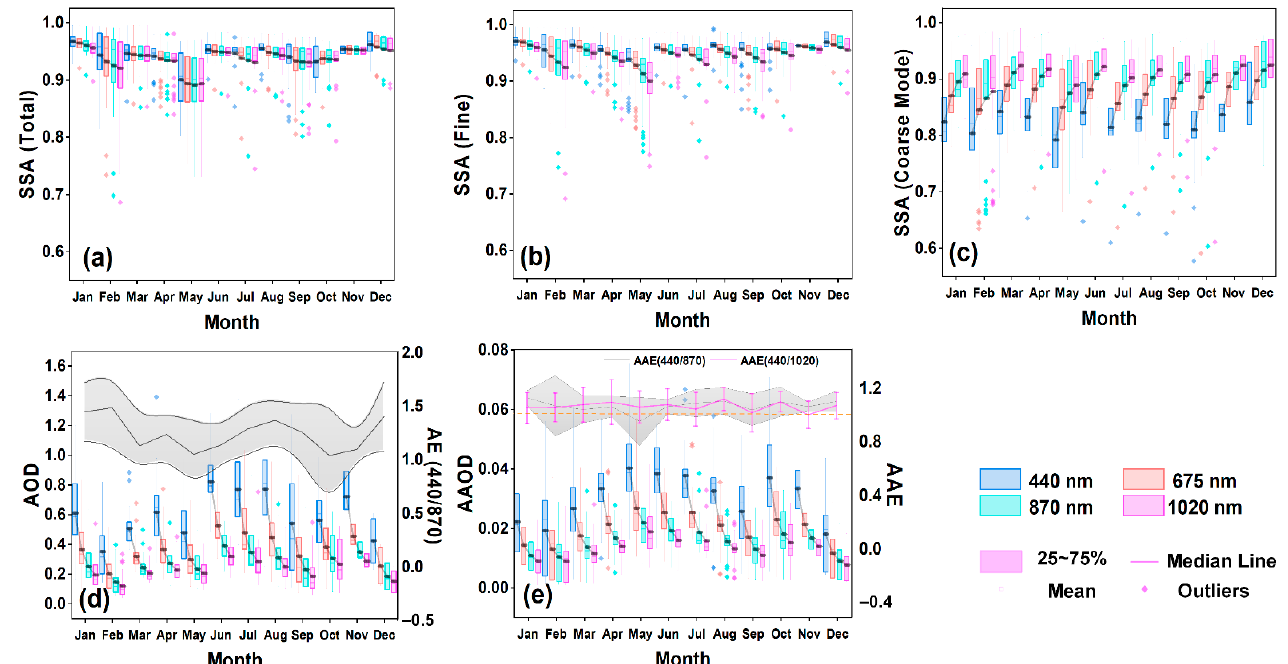
Figure 4. Monthly variation in spectral dependence of SSA of total ( a ), fine-mode ( b ), and coarse- mode aerosols ( c ), AOD ( d ), and AAOD ( e ). The AOP at wavelengths of 440, 675, 870, and 1020 nm is shown in blue, red, cyan, and pink, respectively. The horizontal line within each box represents the median, while the black dot within each box represents the mean value.